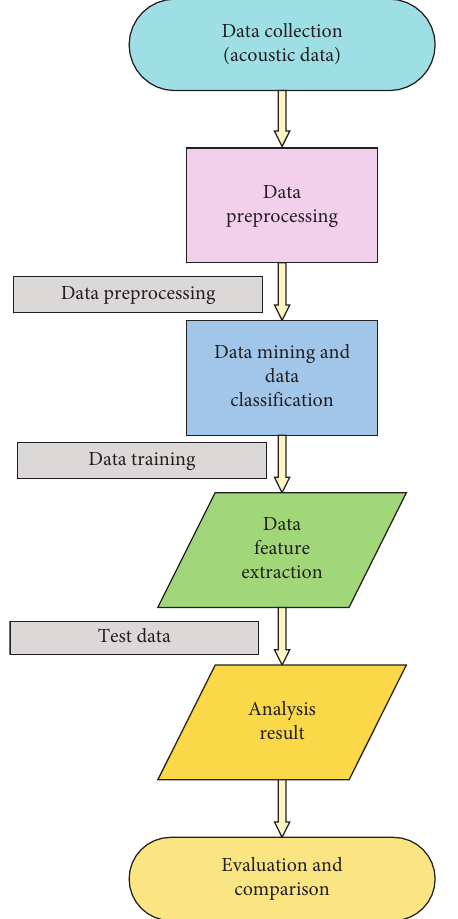
Figure 2: The process of analyzing multiple acoustic